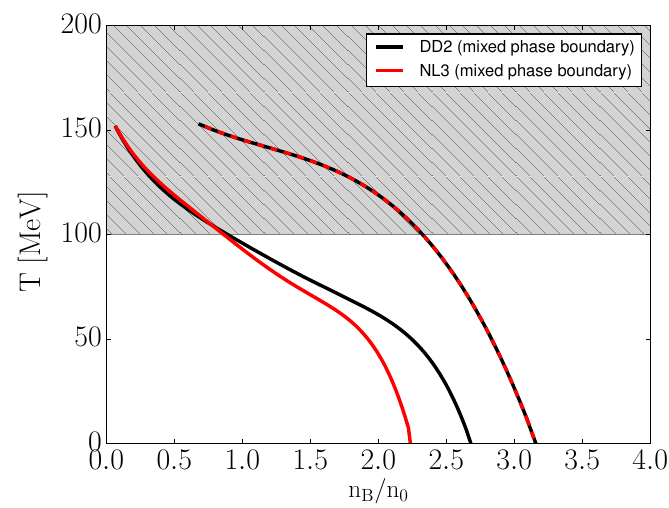
Figure 3. The T – n B phase space of vBag ( B 1/4 χ = 152.7 MeV, K v = 6 The grey region lies outside of the models expected applicability domain. See text for details.